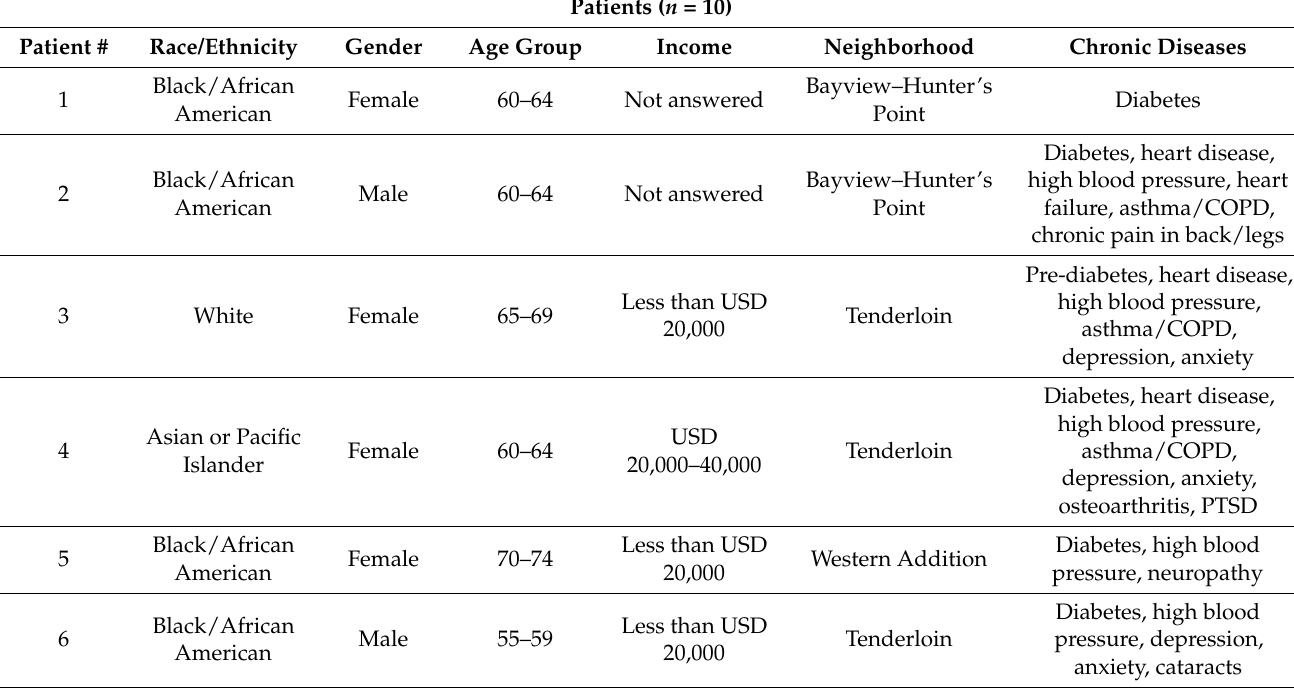
Table 1. Participant